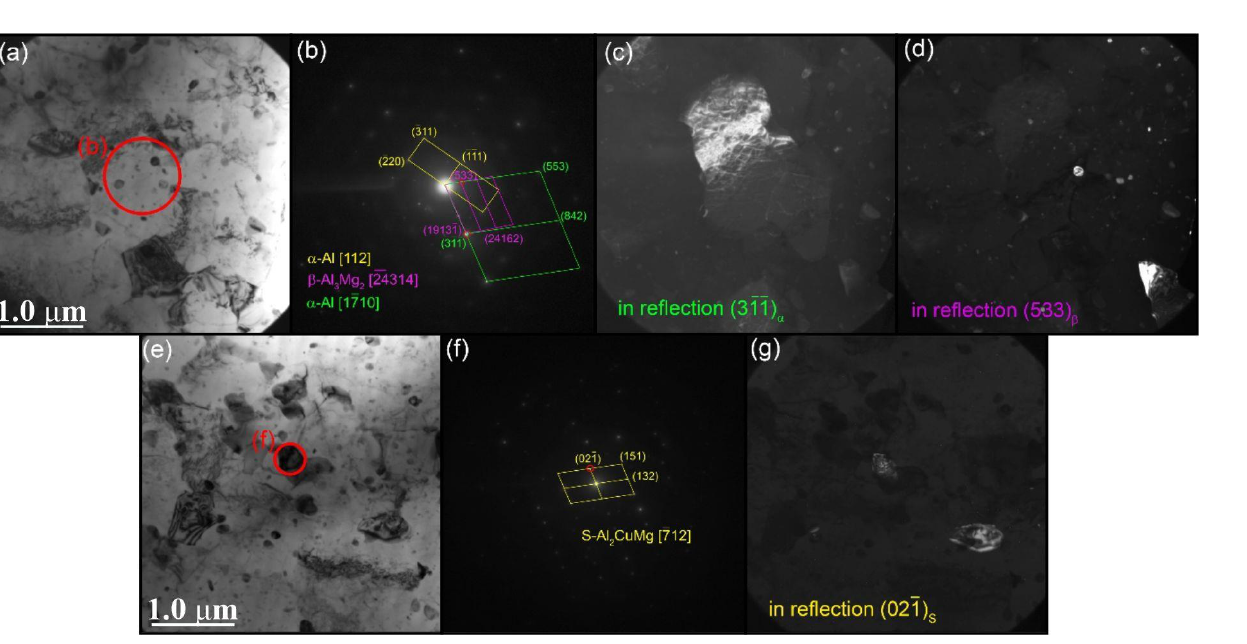
Figure 12. Bright-field ( a , e ) with corresponding SAED patterns ( b,f ) and dark-field ( c , d , g ) TEM images of α -Al(Cu) grain ( a ) as well as β -Al 3 Mg 2 ( d ) and S-Al 2 CuMg ( g ) particles obtained using reflections ( 311 ), (533) and ( 021 ), respectively.